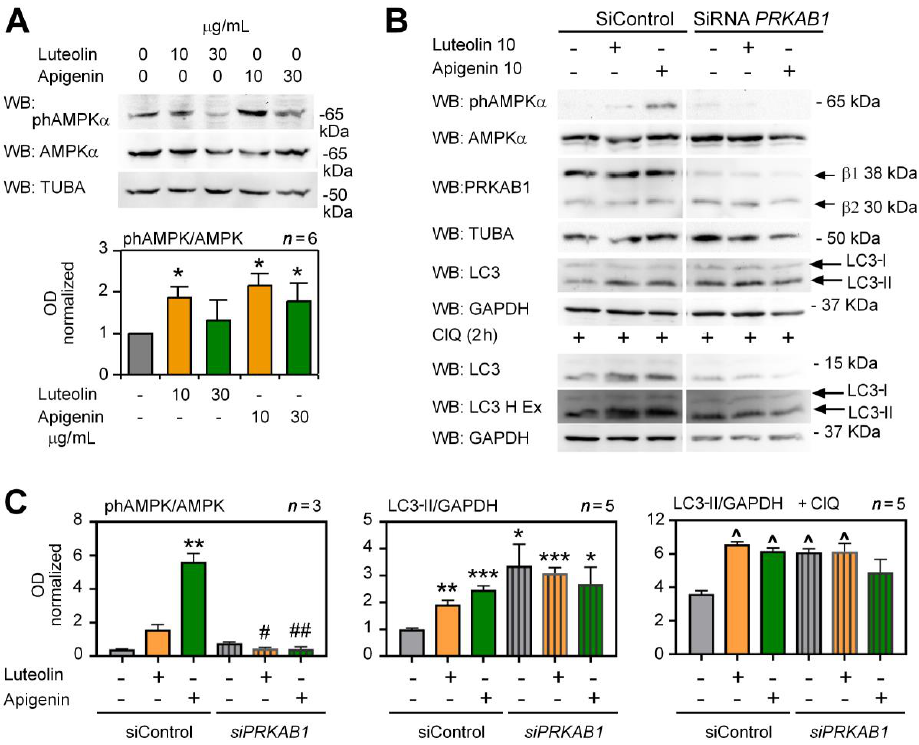
Figure 5. AMPK activation is necessary for autophagy induction by apigenin and luteolin in HepG2 cells. ( A ) Both apigenin and luteolin stimulate AMPK phosphorylation in dose-dependent fashion. HepG2 cells were treated with 10 or 30 μ g/mL of luteolin and apigenin for 6h and phAMPK levels (phT183/172 in AMPK a1/2) were analyzed by WB (SDS-PAGE 8%). AMPK was used as a loading control. The graph below shows the densitometric analysis of data from three independent experiments reloaded two times each ( n = 6). ( B ) Suppression of AMPK activation by silencing of AMPK beta1 subunit (PRKAB1) reduces autophagic flux and response to apigenin and luteolin. HepG2 cells were transfected with a control siRNA or PRKAB1 -specific siRNA, treated for 6 h, and analyzed by WB for the expression of indicated above proteins. ClQ (50 μ M) was added 2 h before lysis to enhance LC3-II accumulation. ( C ) OD analysis of data in ( B ) from n = 3 independent experiments, each analyzed twice at two different exposures. LC3-II in the presence of ClQ was normalized to its mean induction by ClQ (2 h, 50 μ M) when compared to control (-, -) samples. Statistical analysis: Brown – Forsythe and Welch ANOVA followed by Tamhane’s T2 test; * p < 0.05, ** p < 0.01, *** p < 0.001, ∧ p < 0.0001 when compared to control samples or # p < 0.05, ## p < 0.01 when compared to siPRKAB1- treated control samples.